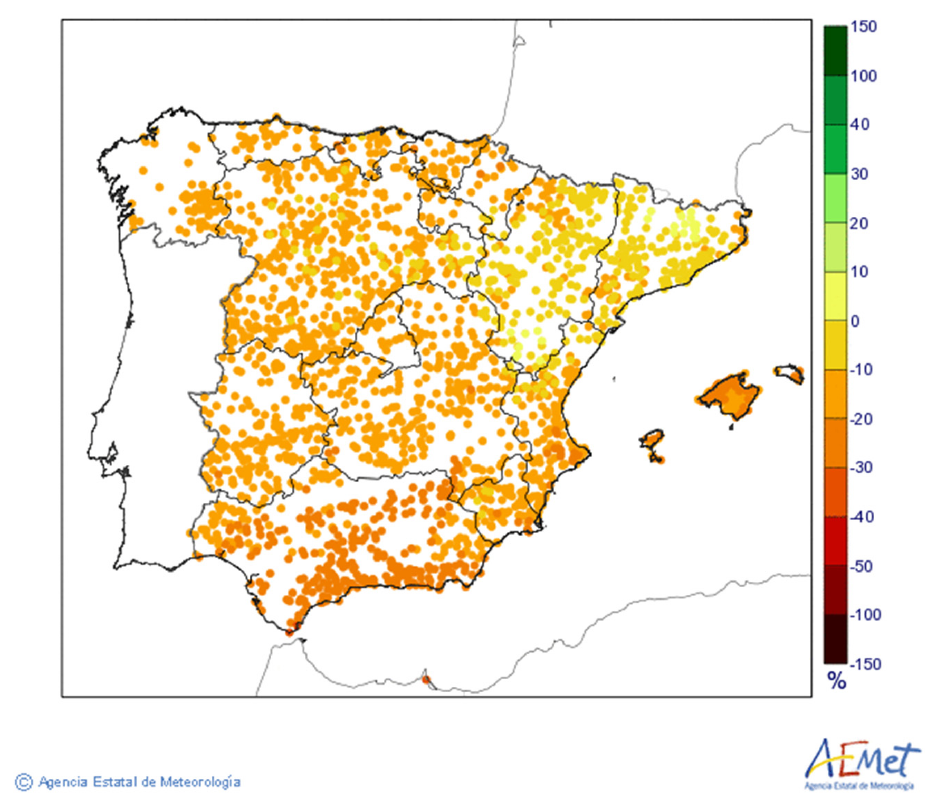
Figure 2. Evolution of the precipitations in the Iberian Peninsula for the horizon 2081–2100 (RCP 8.5. Annual). Source: AEMET [65]. Note: map elaborated in accordance with the models of the Fifth Report of the IPCC.